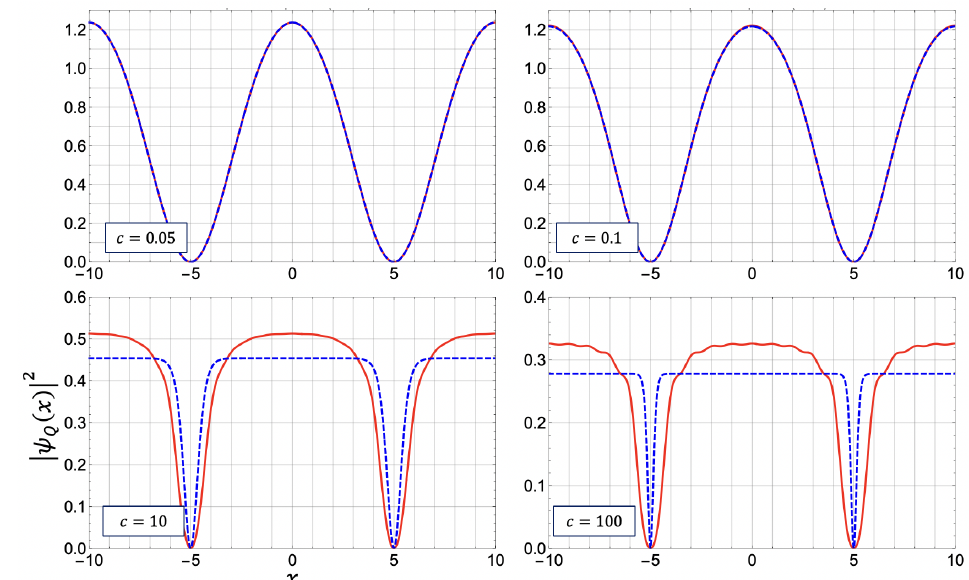
Figure 10. Square amplitudes | ψ Q ( x ) | 2 for the matrix elements (89) (red solid curves) and their classical counterparts (blue broken curves) for coupling constants c = 0.05, 0.1, 10, and 100. The parameters of the elliptic solutions are shown in Table